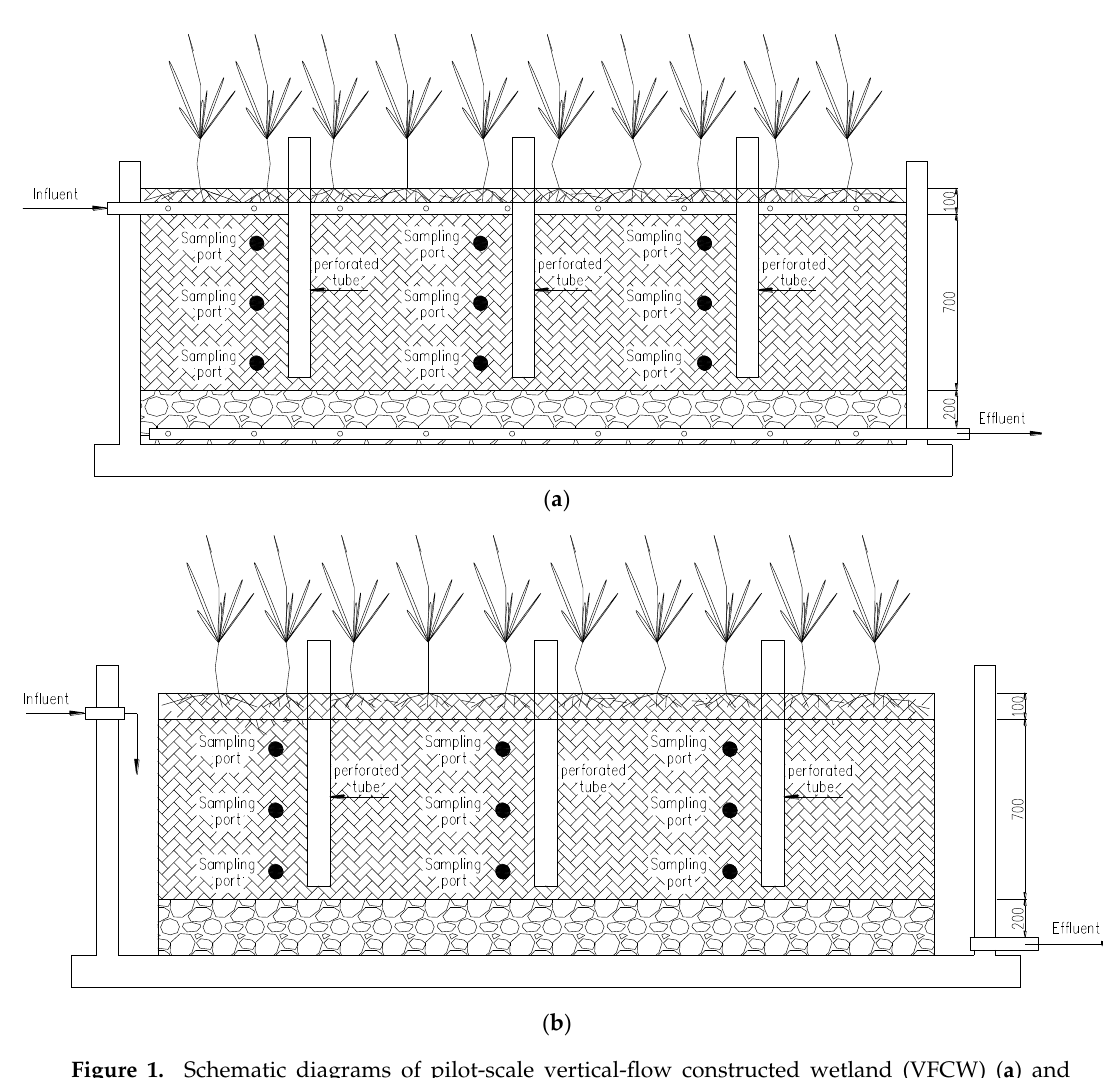
Figure 1. Schematic diagrams of pilot-scale vertical-flow constructed wetland (VFCW) ( a ) and horizontal-flow constructed wetland (HFCW) ( b ) The Phragmites australis was used as the wetland plant. All the thickness units were mm.